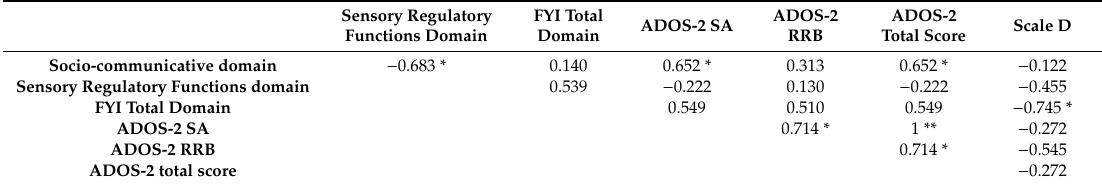
Table 6. Nonparametric correlation between FYI domains and the gold standard measures. Sensory Regulatory Functions Domain